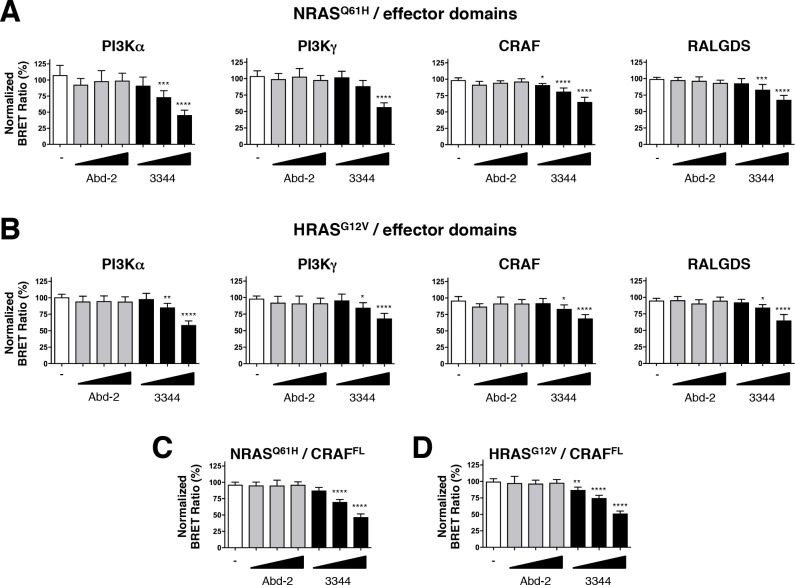
Compound 3344 inhibits NRAS and HRAS-effector BRET-based biosensors.HEK293T cells were transfected 24 hr with plasmids expressing the NRASQ61H (A, C) and HRASG12V (B, D) biosensors together with the indicated RBDs of PI3K, CRAF and RALGDS (A, B) or full-length CRAF (C, D). These were treated with 5, 10 and 20 μM of Abd-2 (grey bars) or 3344 (black bars) compounds for 20 hr. DMSO (white bar) was used as the negative control. Statistical analyses were performed using a one-way ANOVA followed by Dunnett’s post-tests (*p<0.05, **p<0.01, ***p<0.001, ****p<0.0001). Each experiment was repeated at least four times. Where error bars are presented, they correspond to mean values ± SD of biological repeats (A–D). See also Figure 5—figure supplement 1.